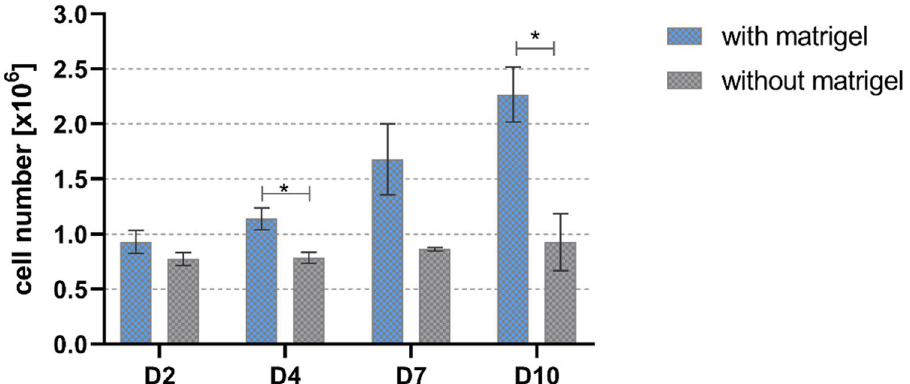
Figure 2. Quantification of HepG2 cell number in printed algMC constructs with and without Matrigel. The DNA content of the scaffolds and therefore corresponding cell number was quantified at different time points (n = 3; mean ± SD; * p <